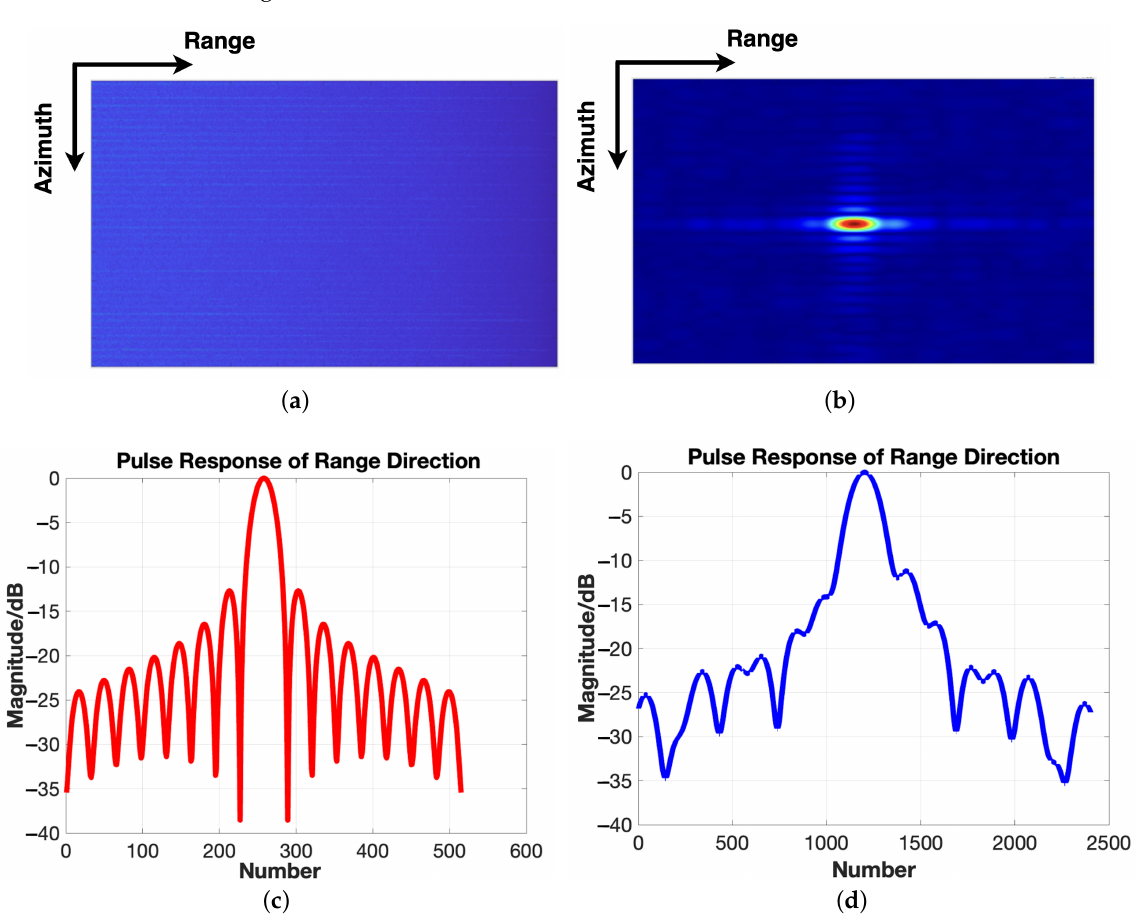
Figure 16. The navigation signal and the imaging result. ( a ) The continuous signal is transferred to segmentation form. ( b ) The focused image of the repeater signal. ( c ) The pulse response of the target in range direction. ( d ) The pulse response of the target in azimuth